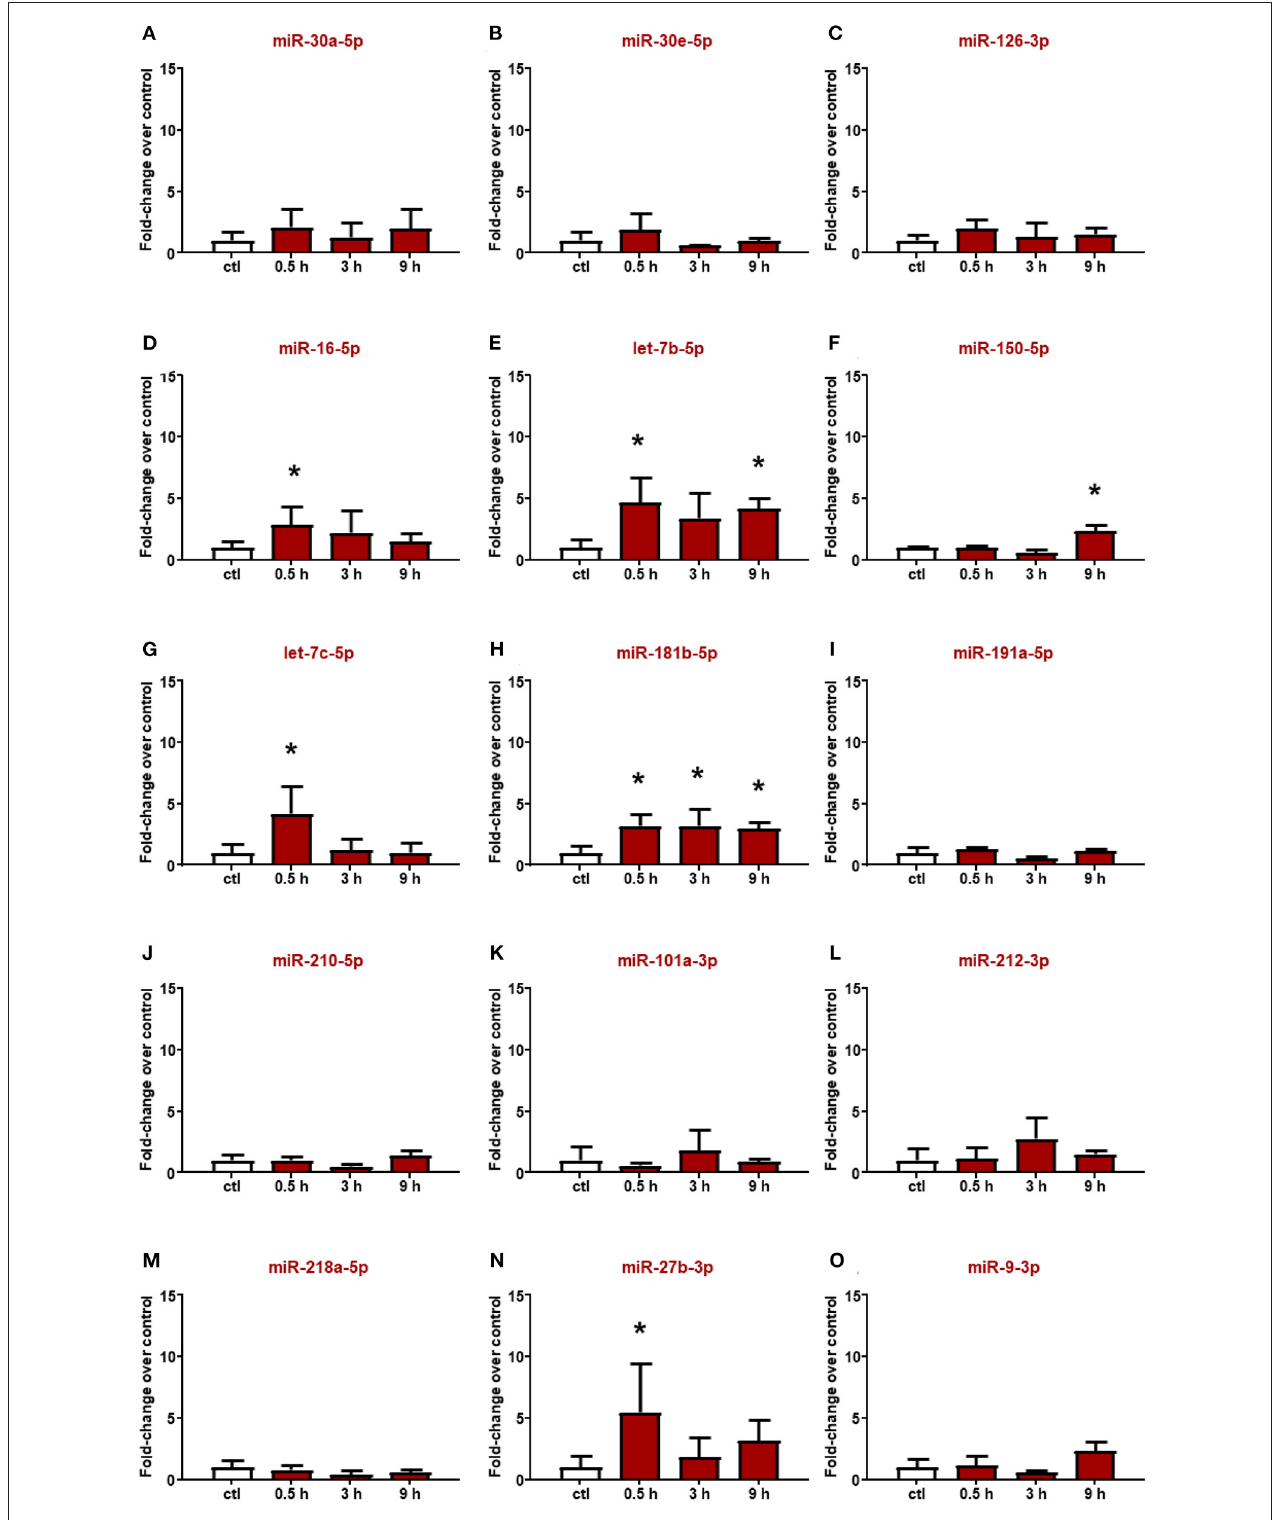
FIGURE 3 | Plasma microRNA expression analysis after intracerebral hemorrhage by real-time PCR. The microRNA levels analyzed by real-time PCR in plasma samples withdrawn from the tail vein of rats subjected to intracerebral hemorrhagic stroke are expressed as fold change over the control group. (A–O) indicate miRNAs evaluated. Each column represents the mean ± SD. The results of the microRNA expression were normalized with respect to U6 snRNA as internal control. n = 5 or 6 per group. * p < 0.05 vs. control group.